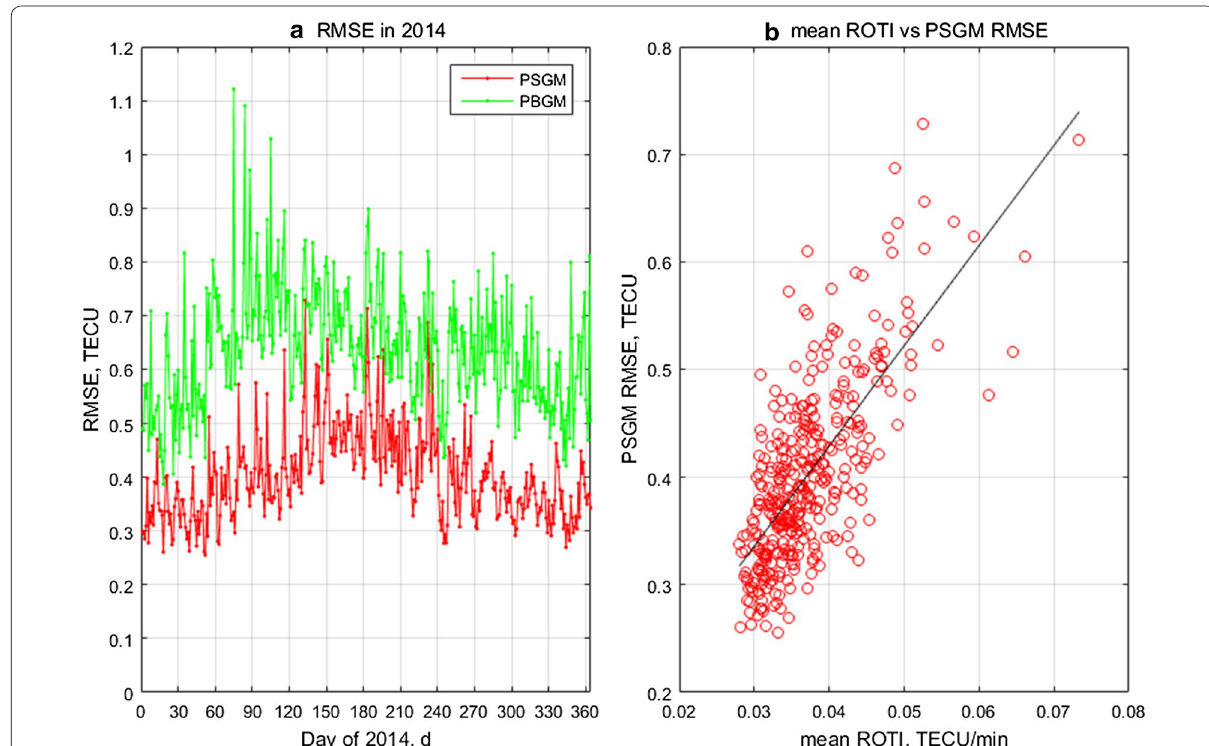
Fig. 6 RMSE of PSGM and PBGM. a RMSE for 364 days in 2014; b a scatter plot for comparison of the PSGM-RMSE to mean ROTI for 364 days in 2014. Slope of the fitted straight line is 9.3